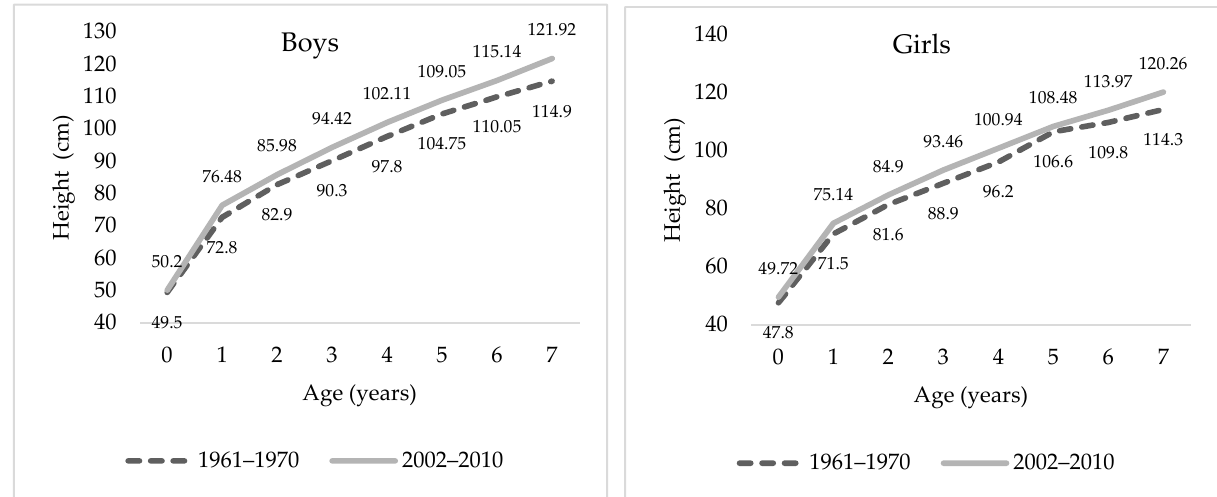
Figure 2. Median height evolution between children aged 0–7 years by sex. Sources: Authors’ calculations based on Luna–Jaspe et al.[2] and Durán et al. [36]